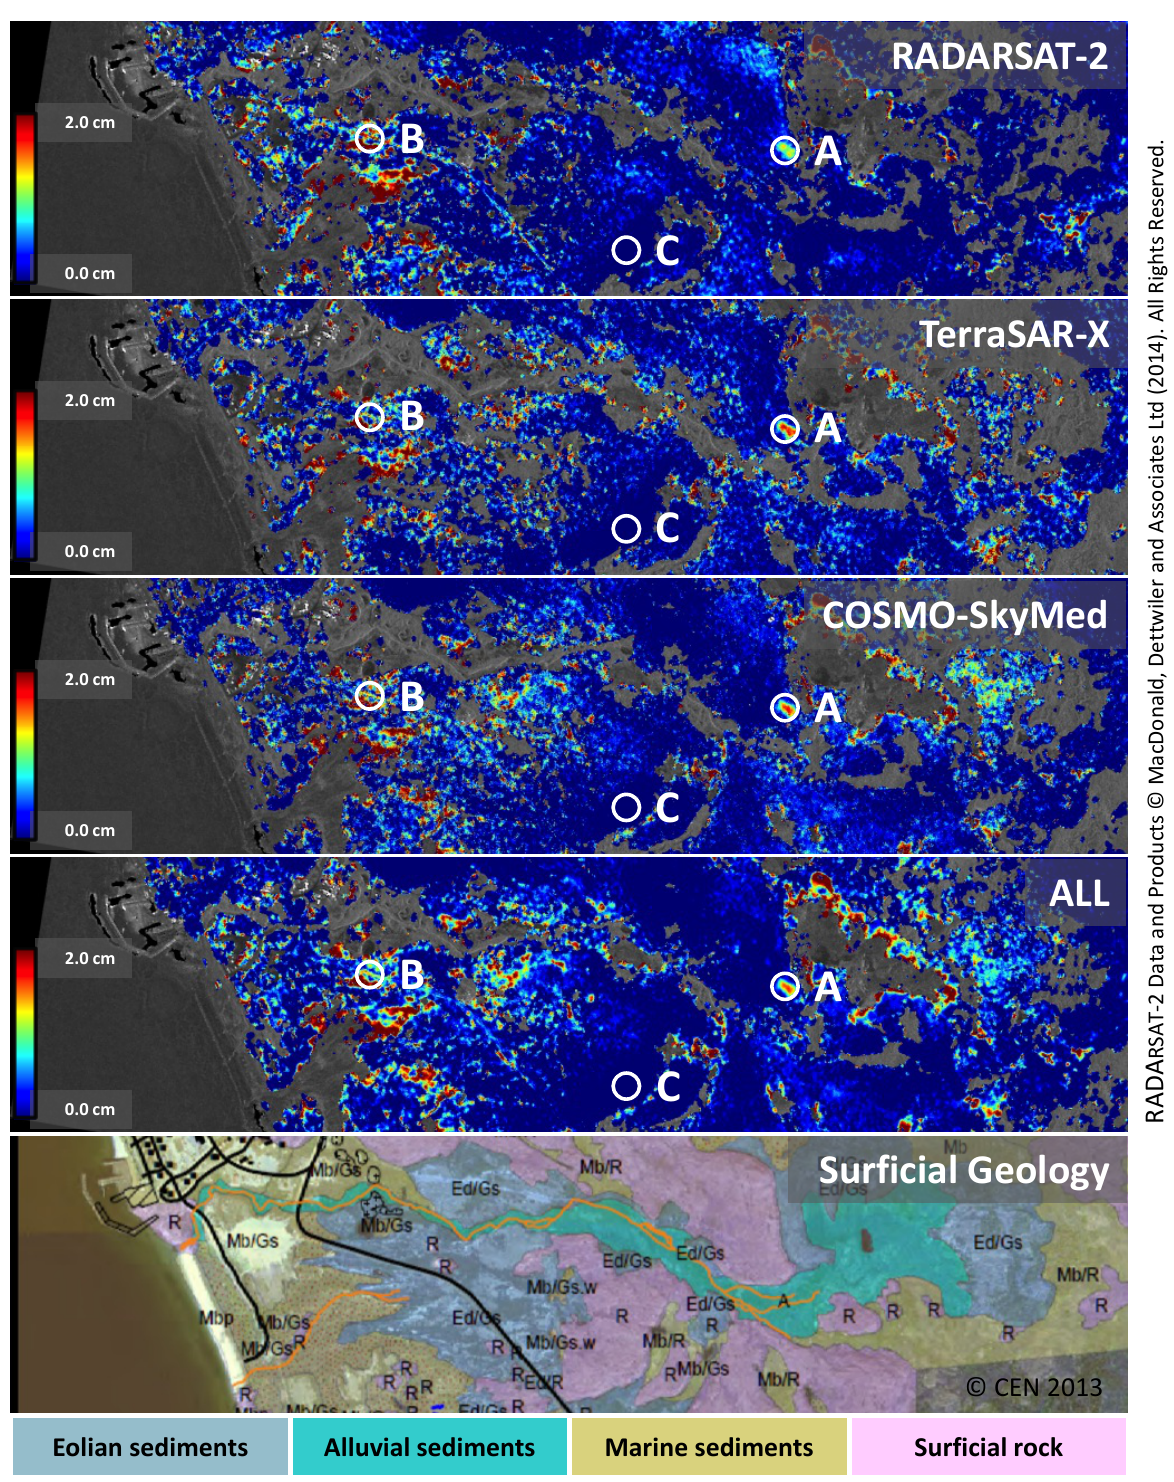
Figure 5. Multi-Track HDS-InSAR derived vertical seasonal deformation magnitude maps overlaid on mean RADARSAT-2 amplitude image for the four test cases (top four frames); corresponding surficial geology map courtesy, University of Laval Centre de Études Nordiques (bottom frame). Deformation time series for points A, B, and C are shown in Figure